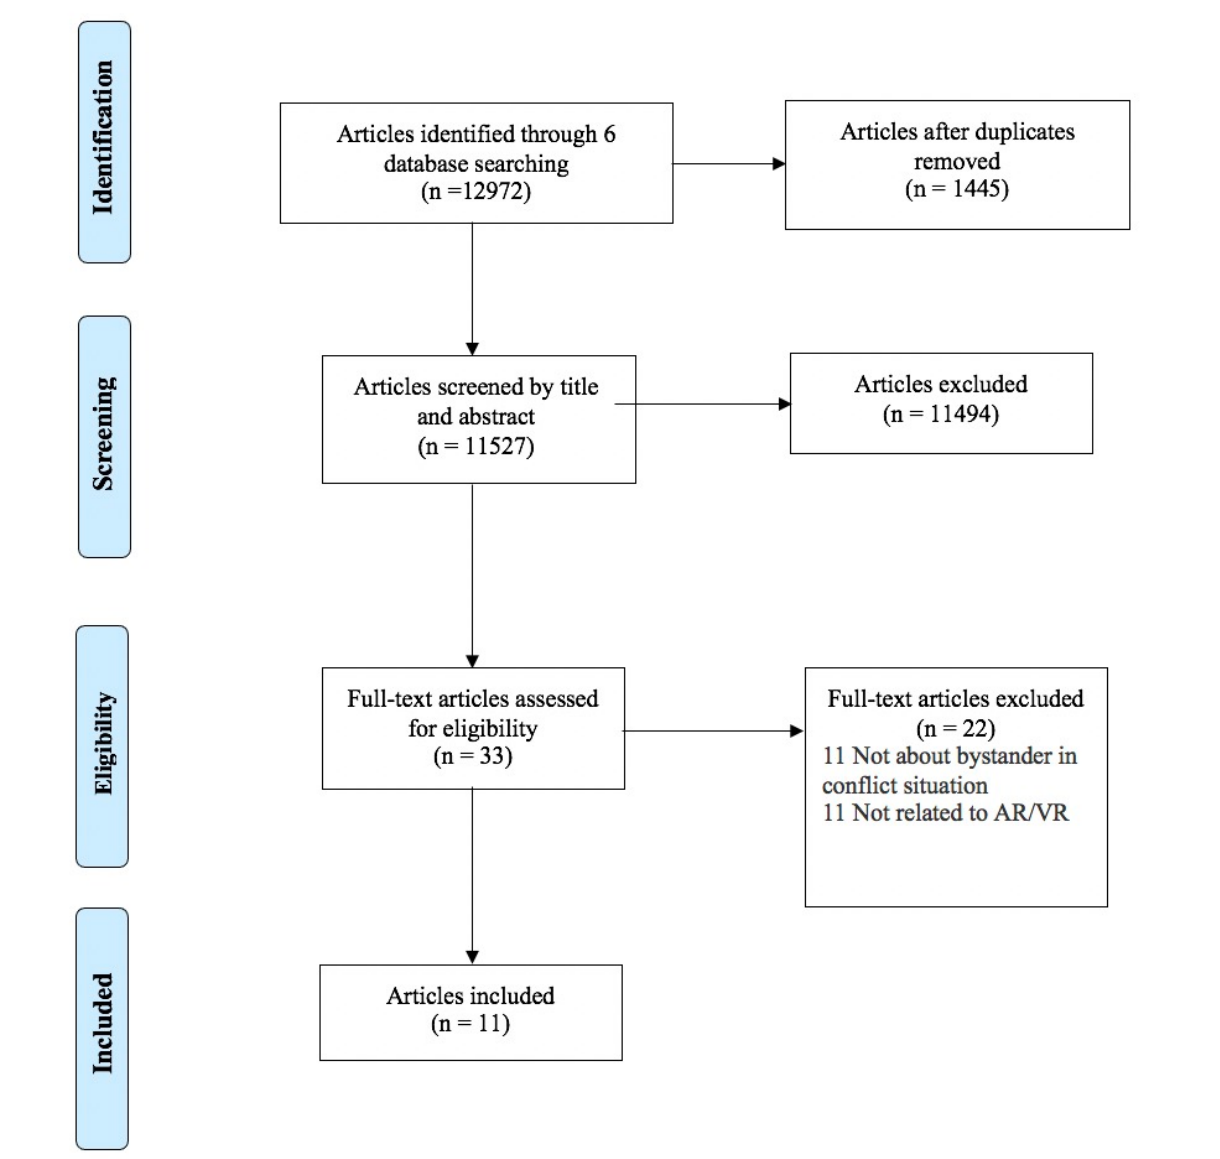
Figure 1. Selection procedure and search results. AR: augmented reality; VR: virtual